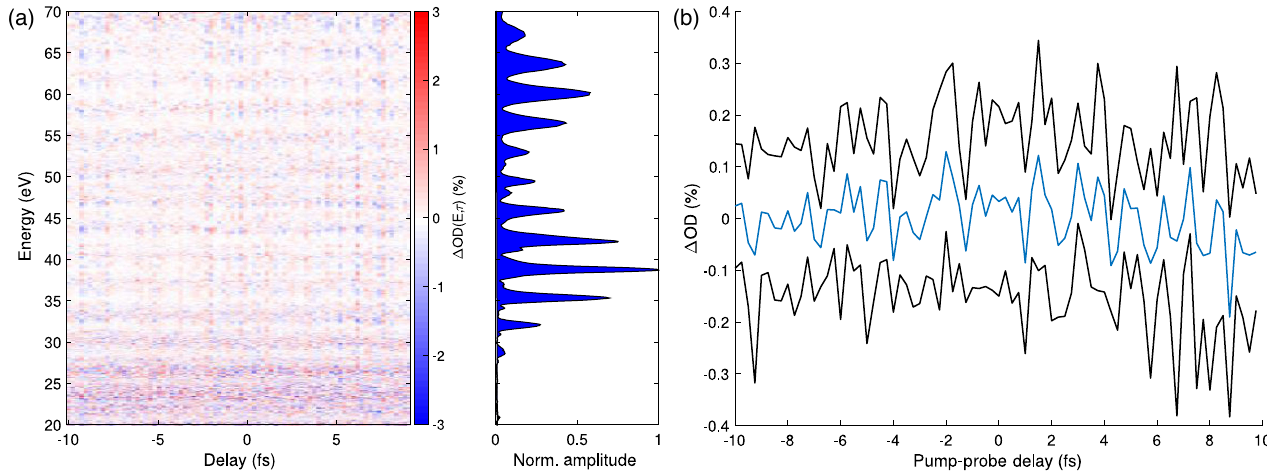
FIG. 8. (a) Transient absorption scan over 20 fs with a delay step size of 250 as. In panel (b), the blue line indicates the integrated change in optical density from 42 eV to 44 eV, while the black lines show the standard error. There is no evidence for field-driven 2 ω dynamics within a sensitivity Δ OD ≈ 4 × 10 − 3